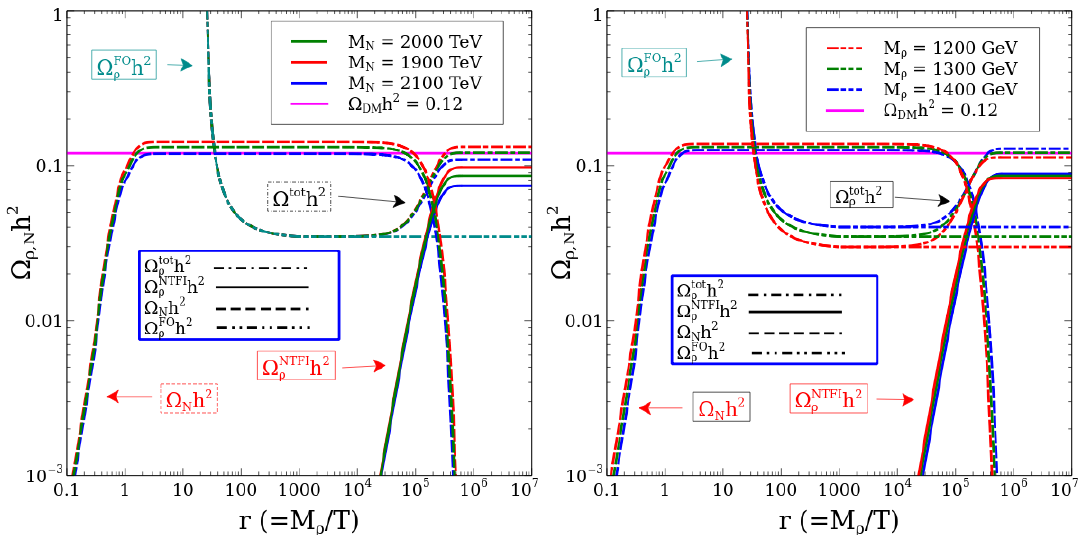
Figure 8 . LP shows the variation of DM relic density produced by three mechanisms namely freeze-out, thermal freeze-in and non-thermal freeze-in for three different values of next to stable particle ( N ) mass, M . In the RP, we have shown the variation of DM relic density produced by N different mechanisms for three different values of DM mass, M . The other parameters are fixed at ρ the following value unless they are varied, M = 2000 GeV, M = 1300 GeV, M = 5000 GeV and N ρ H 2 Y ρ ∆ = 2 . 5 × 10 − 12 . Same convention as in figure